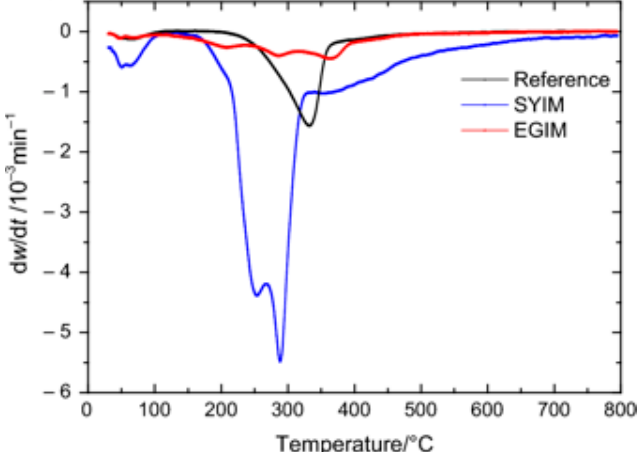
Figure 5. Derivative curves of synergetic fire retardants insulating material (SYIM) and expandable graphite insulating material (EGIM) [27].